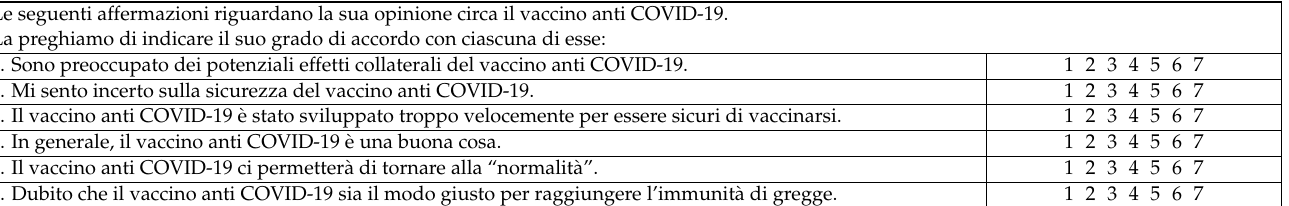
fronteggiare l’emergenza del coronavirus, mi sento in colpa. 3. Pensando all’emergenza coronavirus, se dovessi provocare un danno a qualcuno mi sentirei in colpa per il male